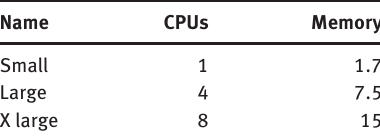
Table 7: VM Instance